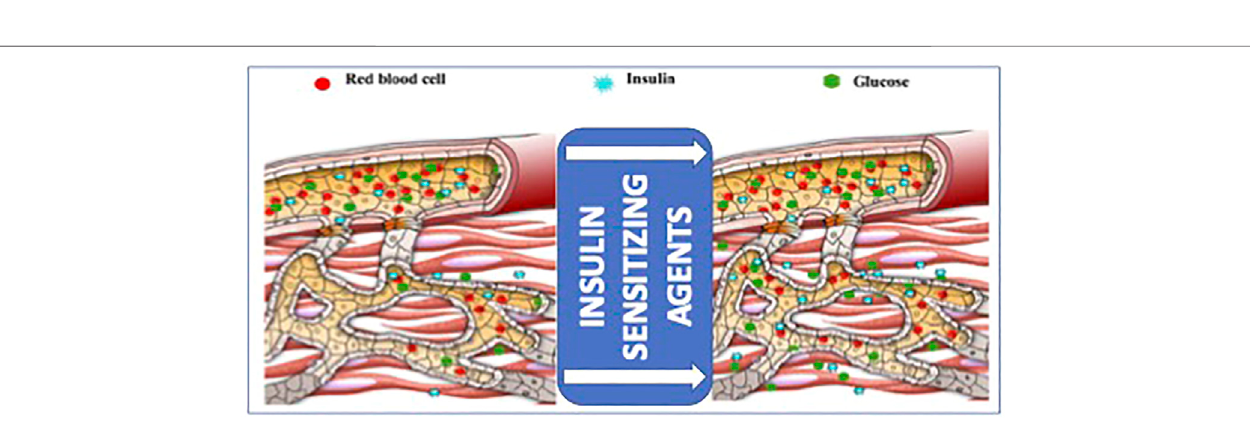
FIGURE 2 | Schematic diagram of the effects of insulin sensitizing agents, including adiponectin, on microvascular recruitment and insulin delivery in the muscle, providing an at least partial explanation of the negative impact of insulin resistance on anabolic signal-related wound healing (adapted from (Zhao et al., 2014)).